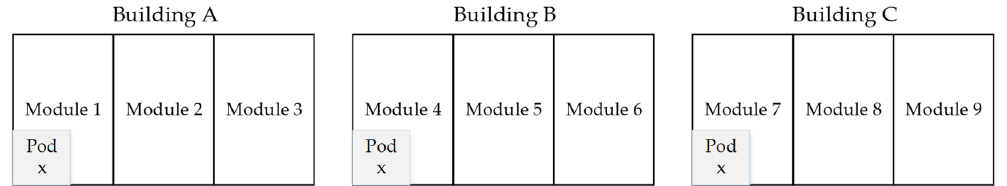
Figure 6. Arrangement of pods and modules in a housing project.